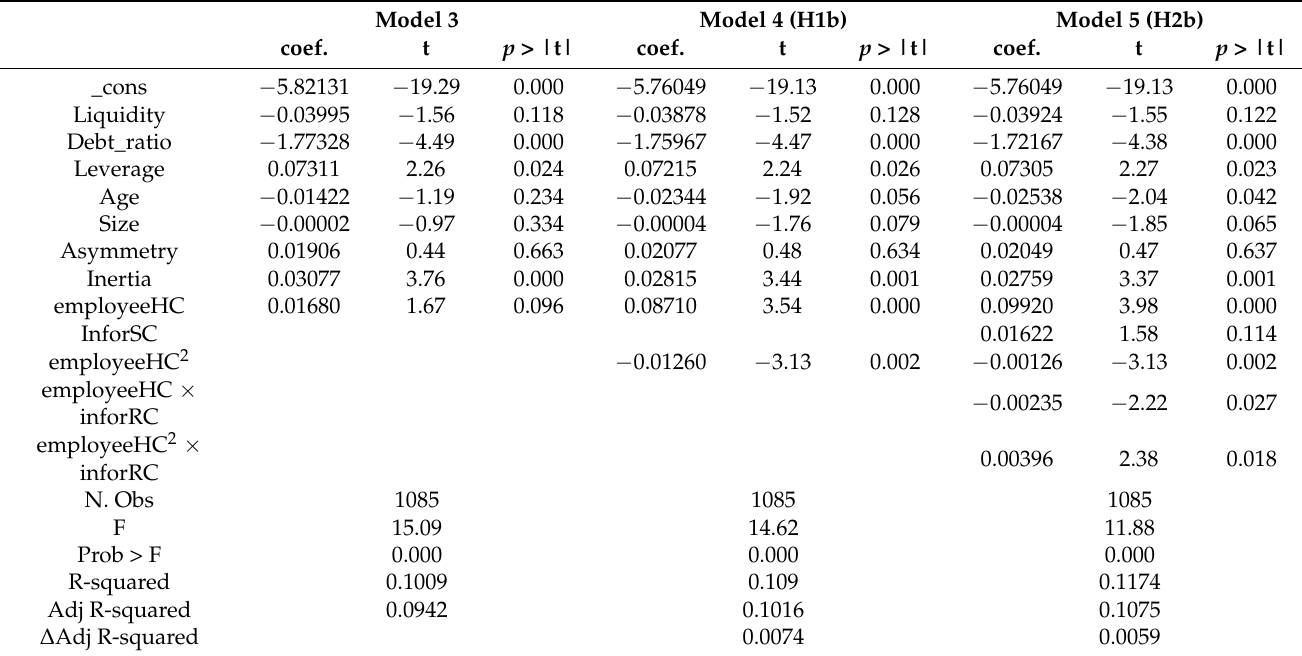
Table 5. General linear regression for employee human capital and